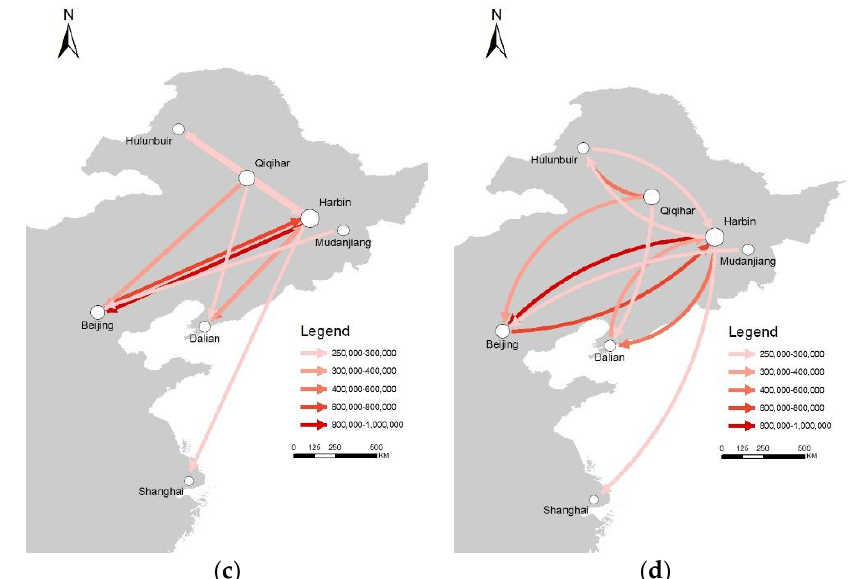
Figure 1. Samples of the experimental materials generated with dataset 1 (Table 1). The cities shown in the maps include Hulunbuir, Qiqihar, Harbin, Mudanjiang, Beijing, Dalian, and Shanghai (not all cities that appear in the four datasets are displayed in the sample maps). SL = straight line; CV = curve; LT = line thickness; and CG = color gradient. ( a ) SL + LT ; ( b ) CV + LT ; ( c ) SL + CG ; and ( d ) CV + CG .